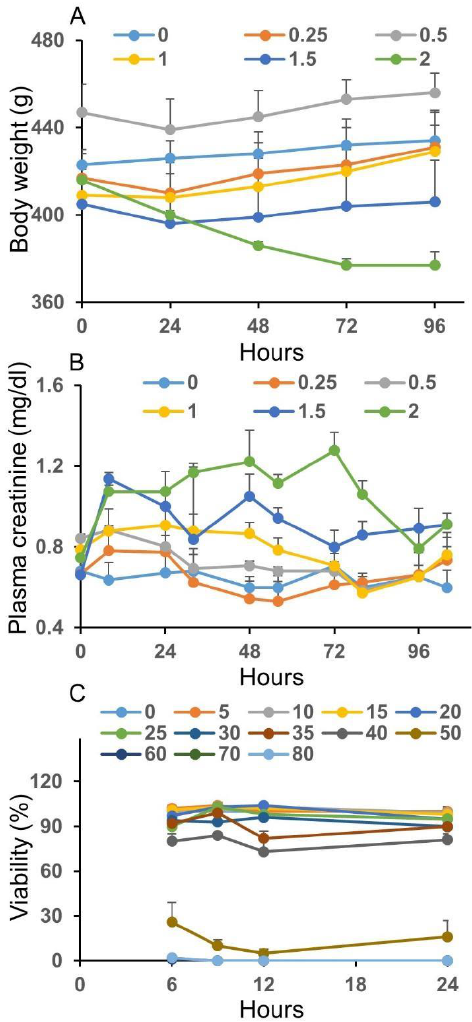
Figure 1. Measurements of injury markers. Effect of a single intraperitoneal injection of mercuric chloride on ( A ) body weight and ( B ) plasma creatinine. ( C ) Effect of mercuric chloride on viability (ATP content) of guinea pig renal proximal tubular epithelial cells. The colored data points and lines represent the responses to the indicated doses of mercuric chloride.